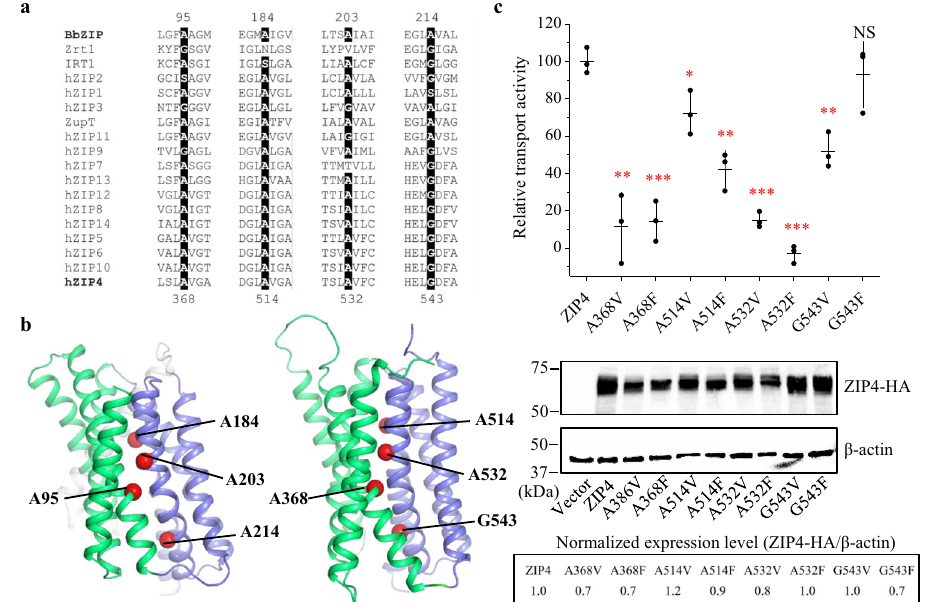
Fig. 9 | Functional characterization of the conserved small residues at the domain interface. a Multiple sequence alignment of representative ZIPs from major subfamilies. Conserved small residues (Ala, Gly, or Ser) identi fi ed at the interface between the transport domain and the scaffold domain are highlighted. b Mapping of the conserved small residues in BbZIP and in human ZIP4. The C α atomsoftheresidueschosenformutagenesisaredepictedasredspheres.Onlythe structure of ZIP4 transmembrane domain (predicted by AlphaFold, https:// alphafold.ebi.ac.uk/entry/Q6P5W5)isshown. c ZinctransportactivitiesofZIP4and the variants. HEK293T cells transiently transfected with ZIP4 or the variants